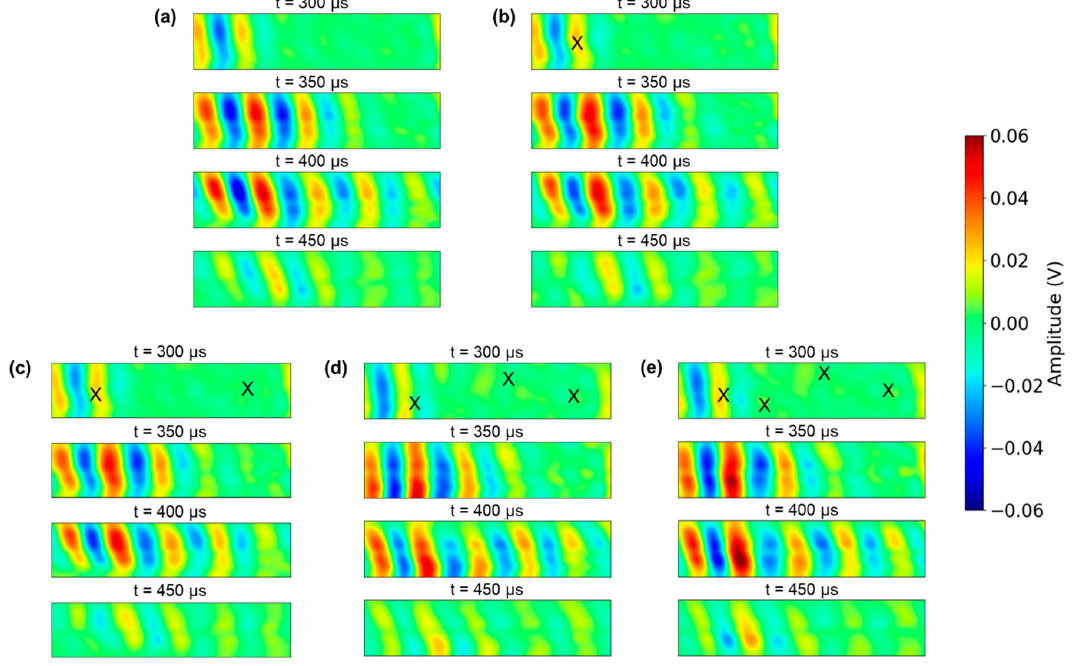
Figure 7. Extracted forward propagating surface waves: ( a ) Case 0 (pristine), ( b ) Case 1 (D1 only), ( c )